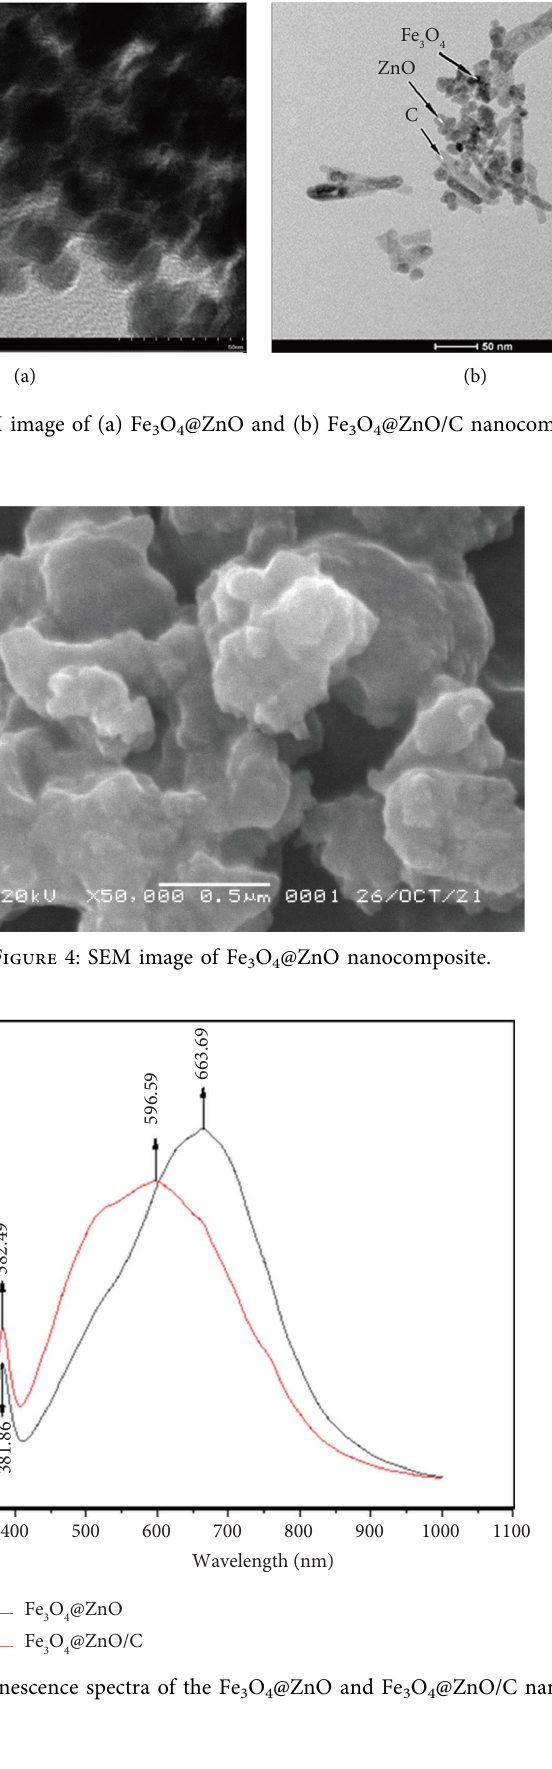
Figure 5: Photoluminescence spectra of the Fe 3 O 4 @ZnO and Fe 3 O 4 @ZnO/C